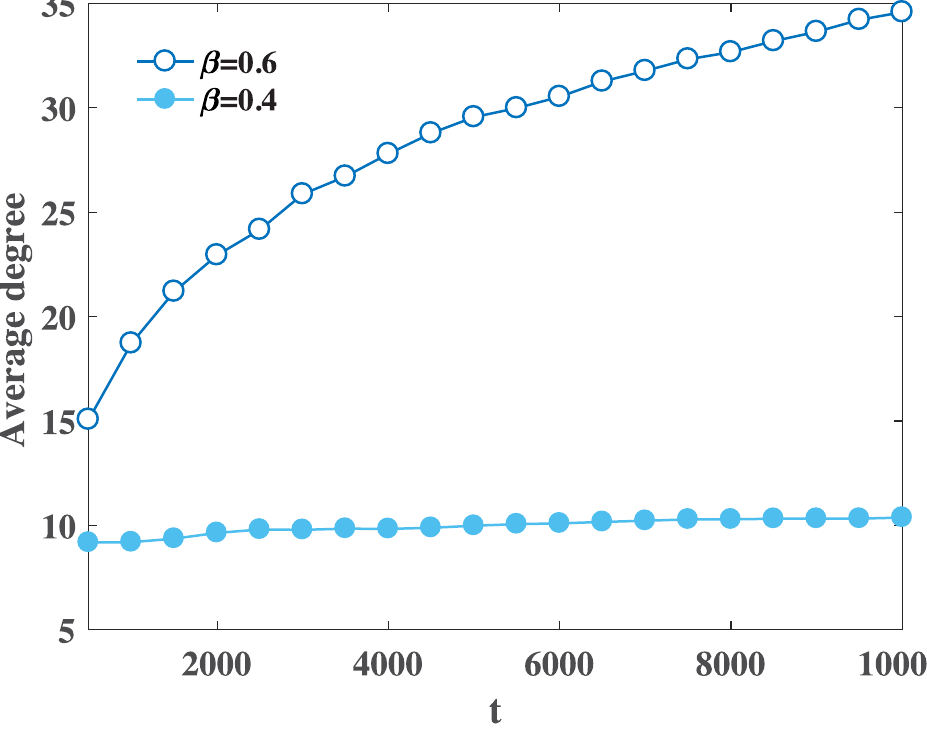
Fig 3. Average degree, � k ð t Þ , is plotted for different size of networks simulated under MSP-2 by setting β = 0.4 (plot in dots) and β = 0.6 (plot in circles), and α = 1 in both the cases. For β = 0.4 average degree reaches to steady state (constant) and for β = 0.6 ( > 0.5) average degree increases